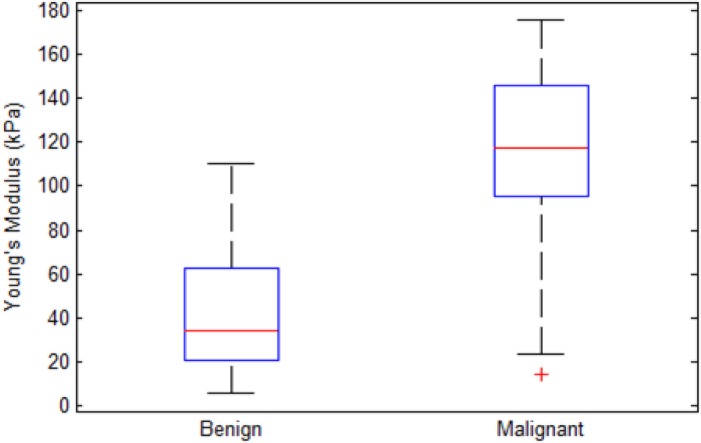
Box-and-whisker plots of SWE values for benign and malignant breast tissue.Young’s modulus values are reported on the y-axis and breast tissues were reported on the x-axis. The central box represents values from the lower to upper quartile (25th–75th percentile). The line through each box represents the median. Error bars show minimum and maximum non-extreme values. ‘+’, are extreme values.